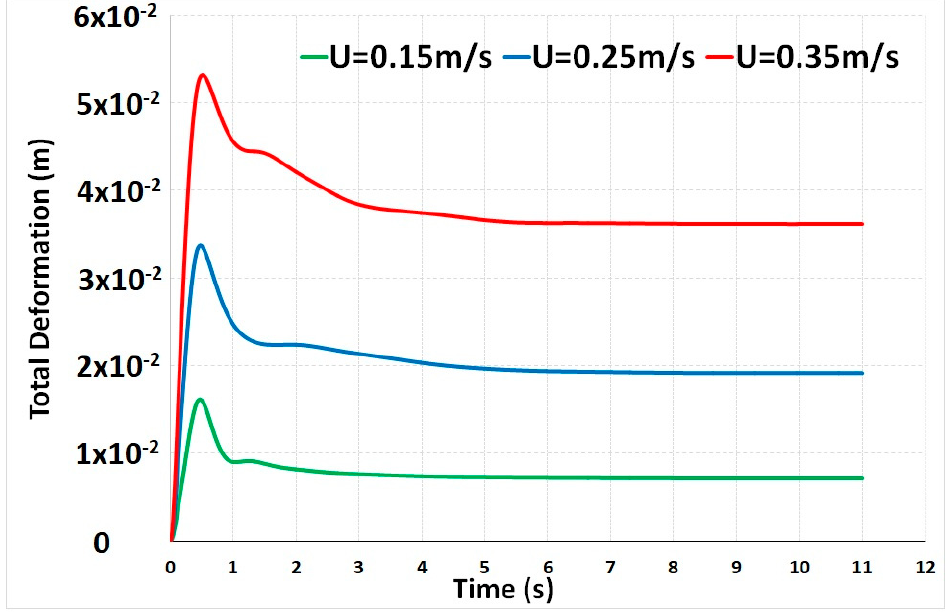
Figure 9. Variation of total deformation of T-shaped flexible beam between t = 0 s and 10 s.